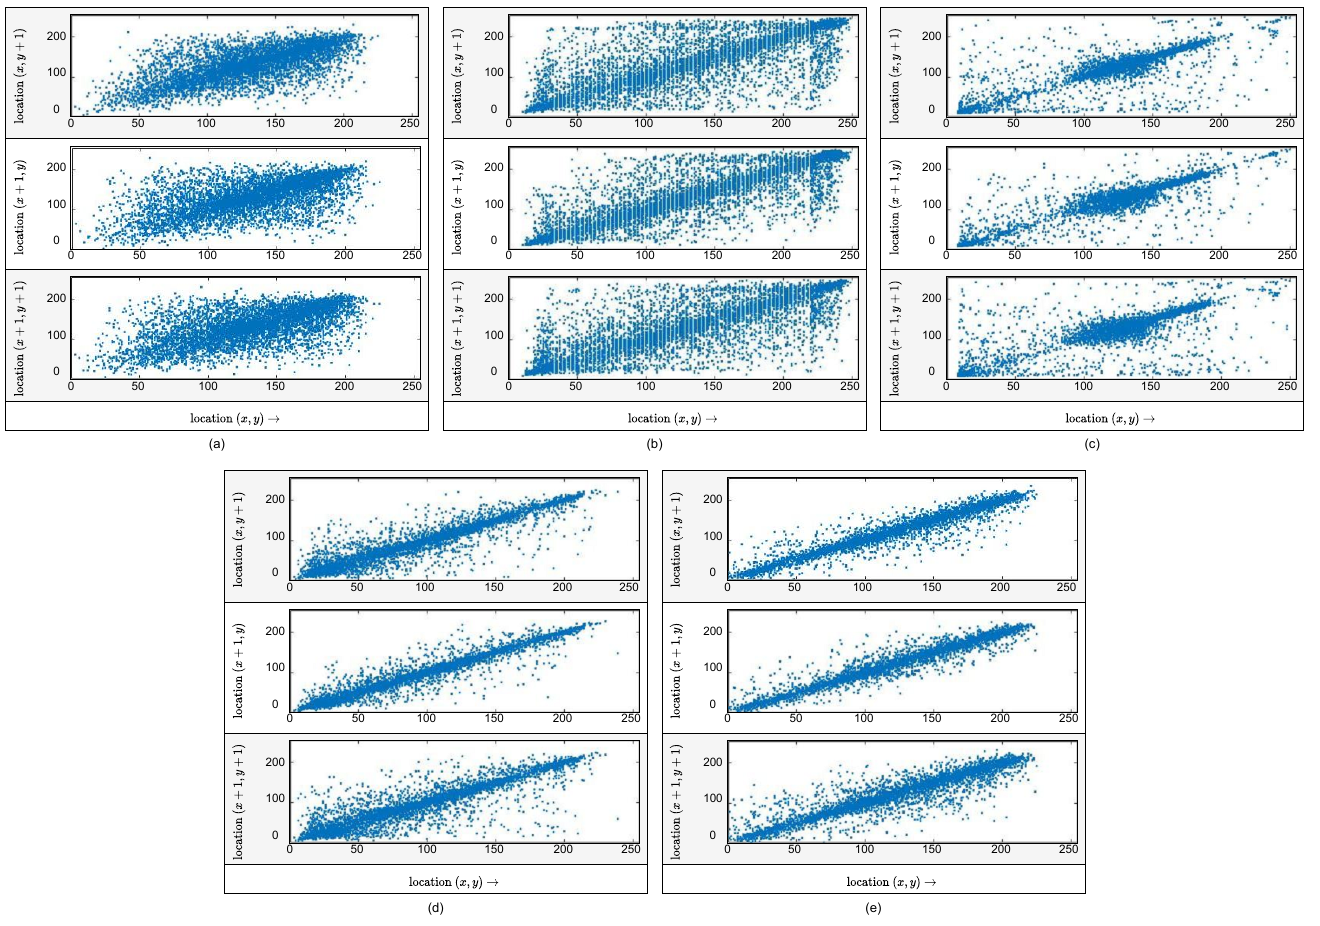
Figure 9. Correlation coefficients of original images, ( a ) Barbara, ( b ) Baboon, ( c ) Cameraman, ( d ) Pep- per, and ( e ) Lena.